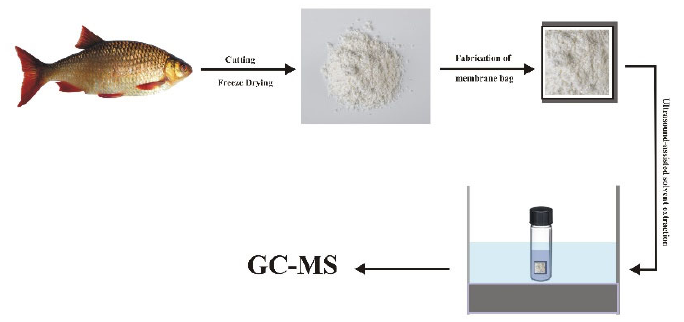
Figure 1. Schematic of the proposed extraction procedure.